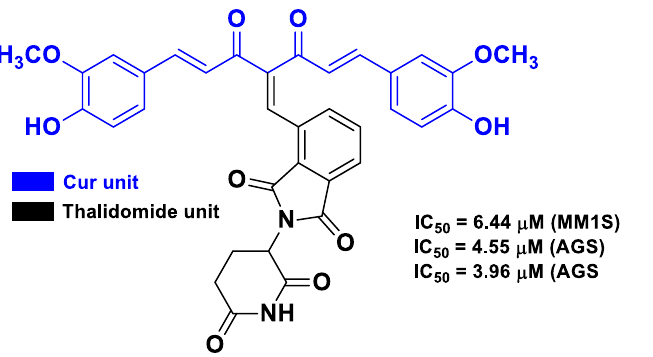
Figure 12. Structure and activity of the most potent hybrid compound developed by Liu et al. [65].